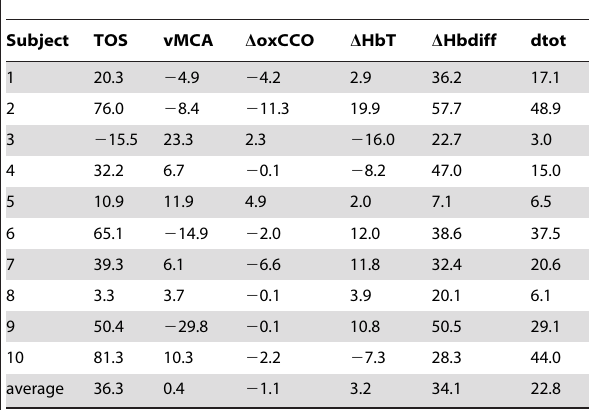
The table is read as follows: consider the TOS entry for subject 4 (i.e., P ( TOS ,4) ) which has value 32.2. This value means that the prediction of the value of TOS for Subject 4 during some challenge was on average 32% improved by model optimisation to data from a different